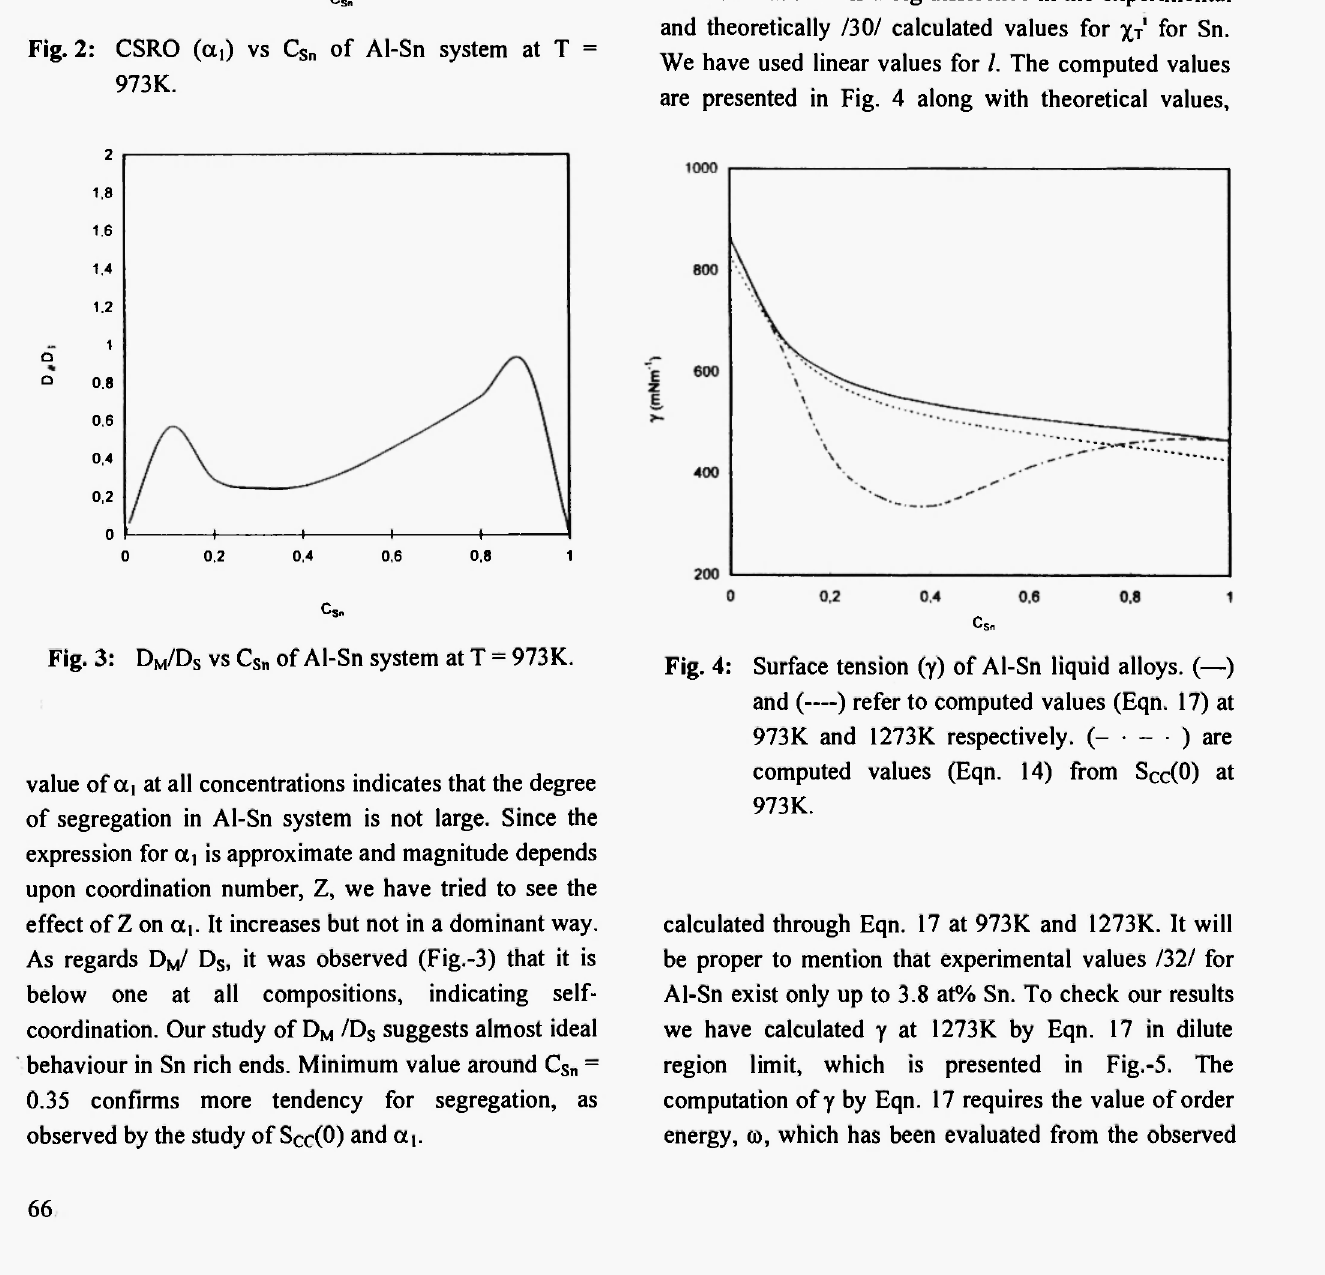
Fig. 2: CSRO (a,) vs C s „ of Al-Sn system at Τ = 973K.